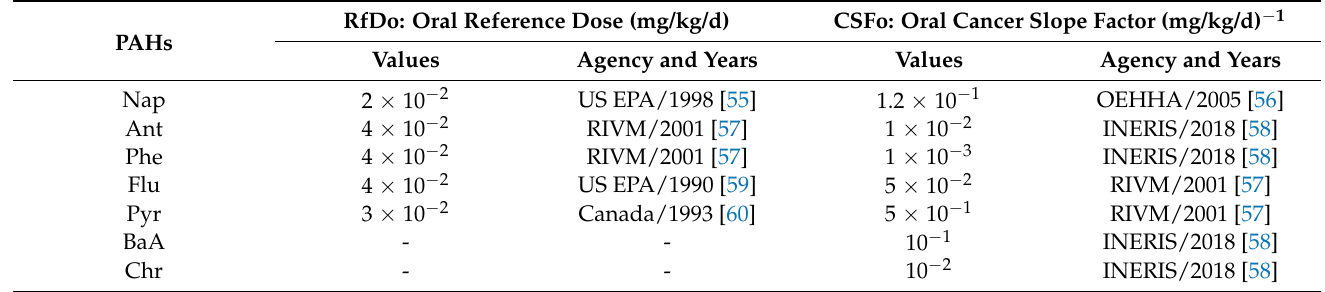
Table 1. RfDo for non-carcinogenic effects and CSFo for carcinogenic effects. RfDo: Oral Reference Dose (mg/kg/d) CSFo: Oral Cancer Slope Factor (mg/kg/d) − 1 PAHs Values